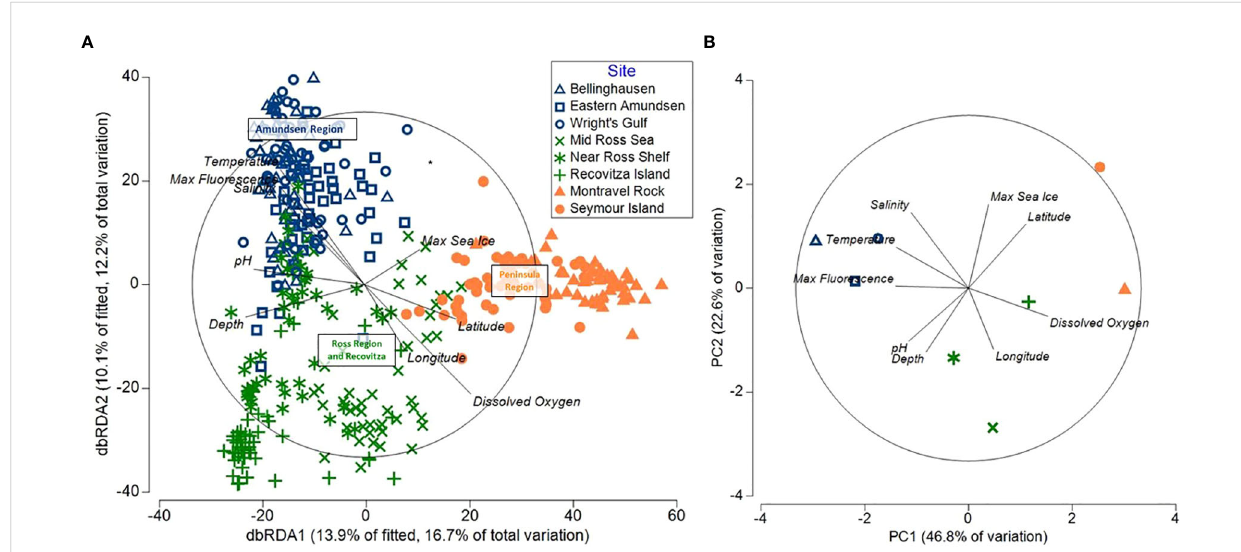
FIGURE 3 (A) Distance-based redundancy analysis (dbRDA) plot based on the calculations of a zero-adjusted Bray-Curtis similarity matrix showing community composition relationships where proximity estimates community similarity with Principal Component Analysis (PCA) aligned and overlain on top to show environmental trends. Asterisk indicates the one image with a drop stone found in Seymour Island. (B) PCA of the environmental